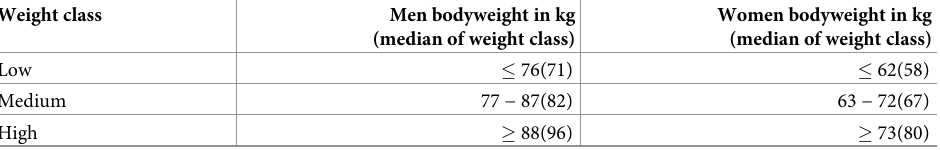
Table 1. Classes of bodyweight (in kg).